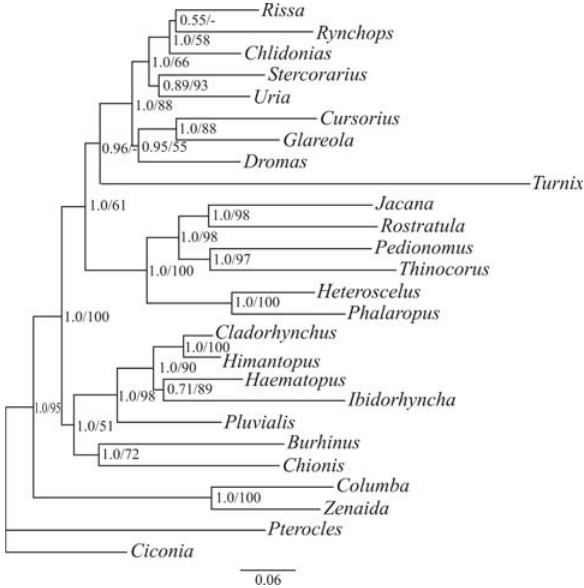
Figure 2 - Consensus Bayesian tree derived from the molecular data set. Numbers at nodes are posterior probabilities /parsimony bootstrap percent